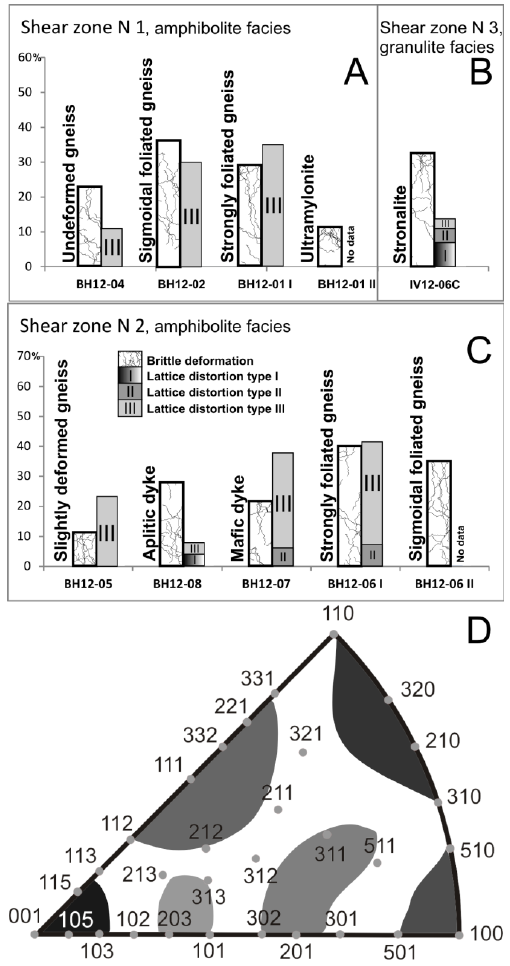
Figure 14. (a) Histogram representing the percentage of deformed zircon grains in each sample in the profile across amphibolite shear zone 1. The succession of rocks is from less deformed to myloni- tized. (b) Histogram representing the percentage of deformed zir- con grains in granulite shear zone 3. (c) Histogram representing the percentage of deformed zircon grains in each sample in the pro- file across amphibolite shear zone 2. The succession of the rocks is equivalent to Fig. 1b. (d) Collective misorientation axes distribution density plot based on 60 analyzed grains from different lithologies. The intensity of the grey shading is proportional to the misorienta- tion axes density.